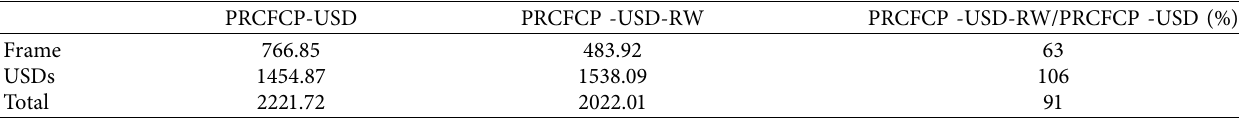
Table 3: Average energy dissipation of the frame and USDs under 22 ground motions (unit: kN · m). PRCFCP-USD PRCFCP